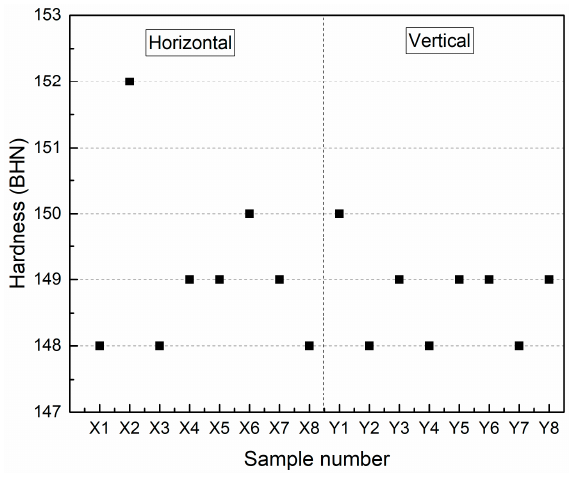
Figure 7. Brinell hardness for horizontal and vertical specimens.